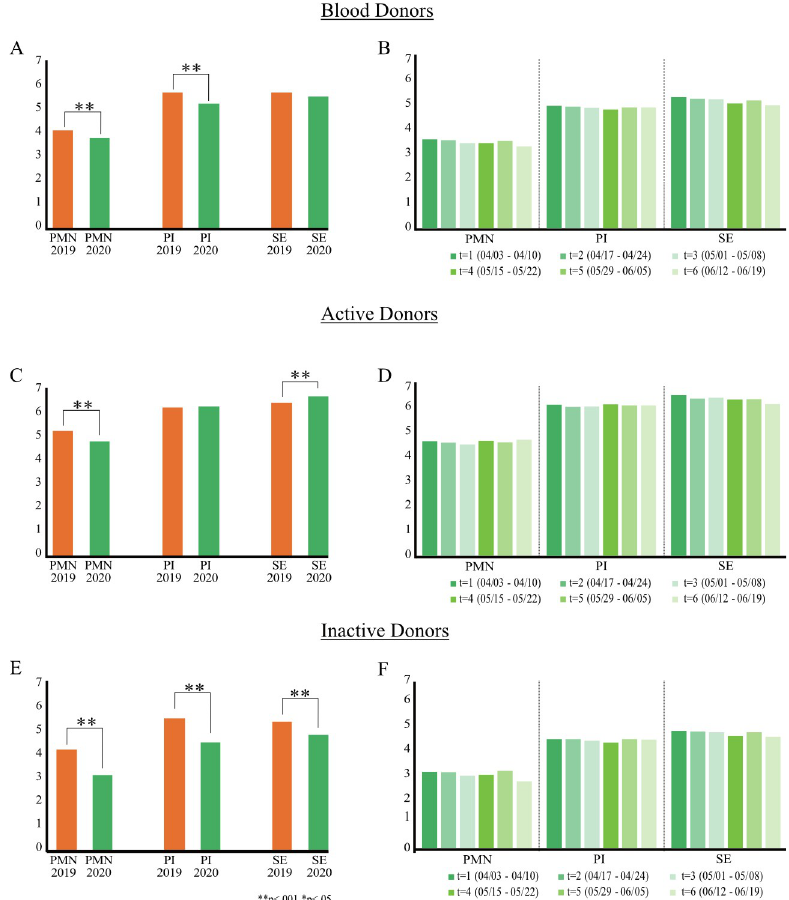
Fig 2. Effect of COVID-19 on blood donor motivations. (A) Comparison of reported mean values of personal moral norms (PMN), perceived impact (PI), and self-efficacy (SE) by blood donors (overall) between pandemic phase (t 1 , 2020/04) and pre-pandemic phase (2019/04). Significant changes between waves are marked. (B) Reported mean values by blood donors within the pandemic phase (t 1 to t 6 ). (C) Same as (A) only for active donors. (D) Same as (B) only for active donors. (E) Same as (A) only for inactive donors. (F) Same as (B) only for inactive